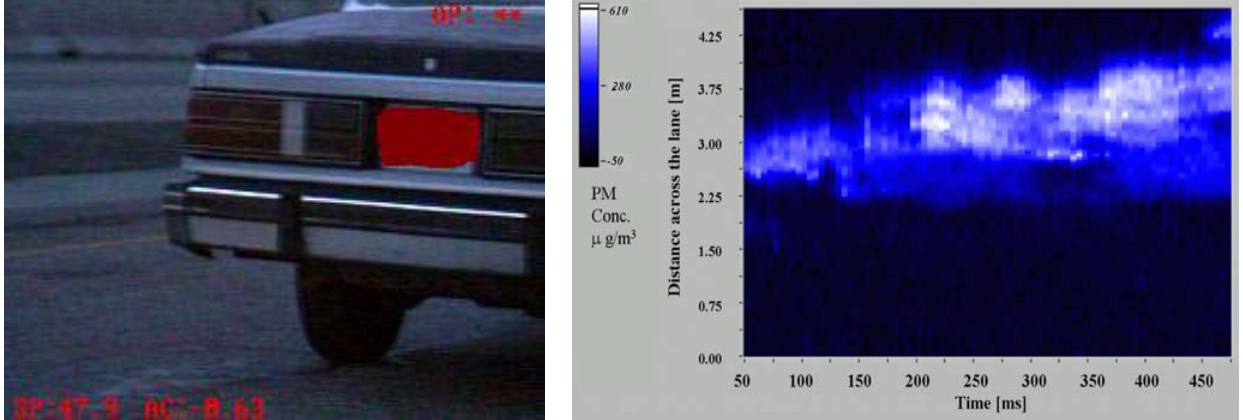
Figure 4. Gasoline vehicle passing through the LiDAR system (the license plate has been obscured for privacy reasons) deployed near Boise, Idaho, USA in winter 2004. On the right panel the excess PM mass concentrations emitted by the gasoline vehicle are represented in an intensity chart. The concentrations were calculated from the LiDAR returns after correcting for the non-linearity of the detector. Range- and extinction-corrections have been applied after the background signal has been subtracted. No correction has been applied to account for the finite temporal pulse width of the laser. The abscissa axis represents the time (in milliseconds) elapsed after the vehicle passed through the system. The ordinate axis represents the distance across the road r from the main unit (in meters). The color scale represents the PM mass concentration (in µg/m 3 ) with white being the highest concentration; evident is the plume